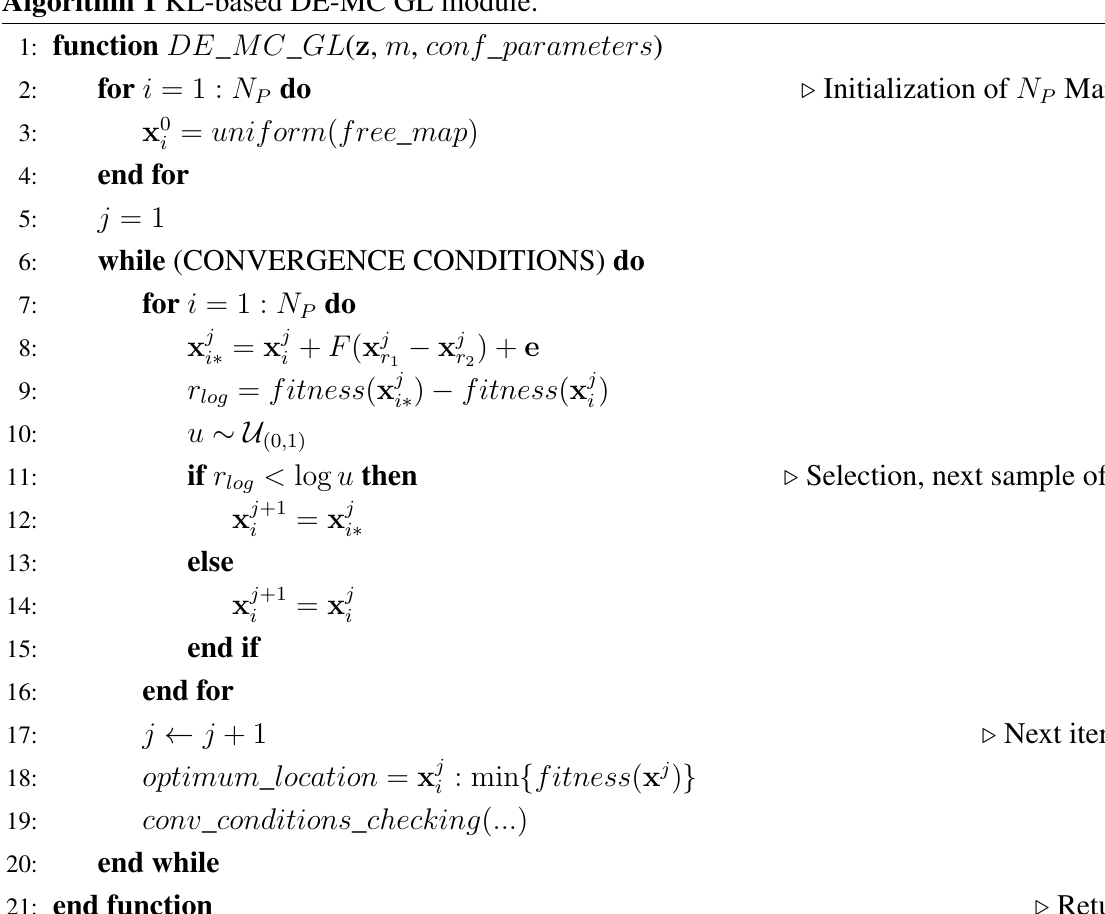
Algorithm 1 KL-based DE-MC GL